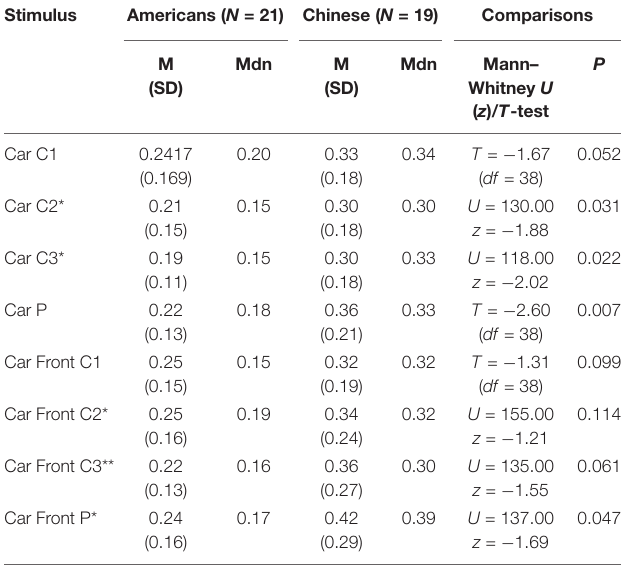
TABLE 3 | Statistics of arousal levels.